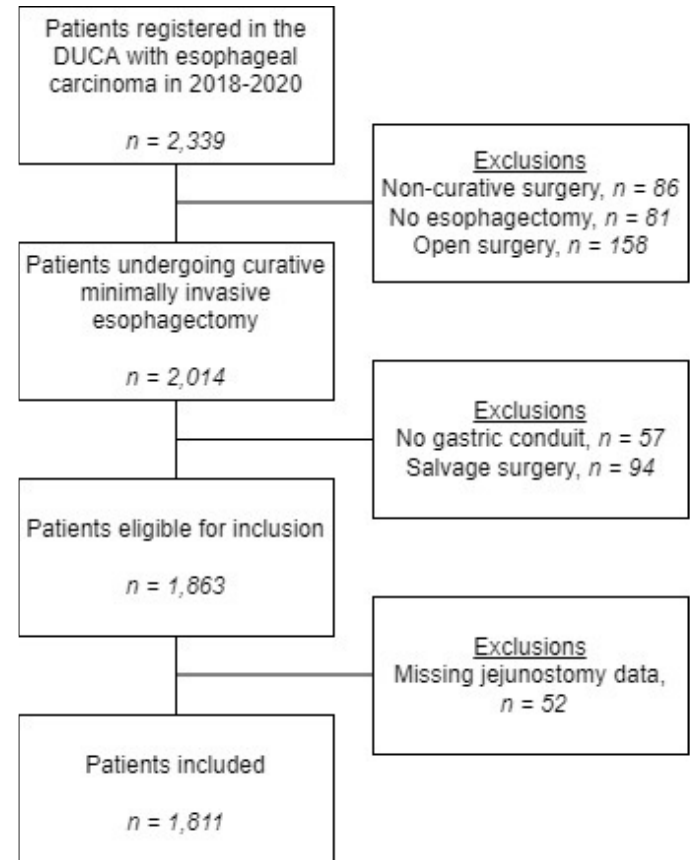
Figure 1. Flowchart of included patients.